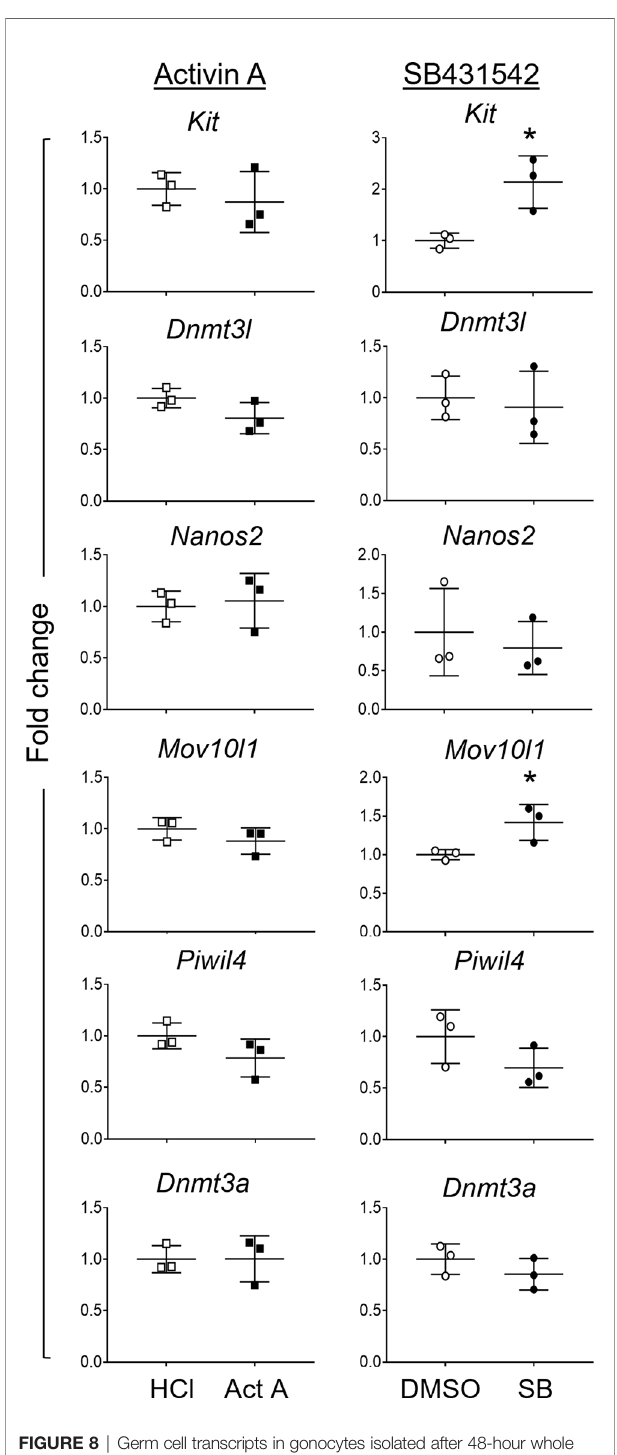
FIGURE 8 | Germ cell transcripts in gonocytes isolated after 48-hour whole testis culture. Germ cells were isolated via FACS from E13.5 testes cultured for 48 hours with 50 ng/mL activin A (Act A, black squares) or 10 µM SB431542 (SB, black circles) and their controls (white symbols). Transcripts of germ cell genes were measured by qRT-PCR. Treatment groups are presented as fold change compared to control (n=3 individual testes per group). Data were normalised to the Canx housekeeper gene, and presented as mean ± SD. Signi fi cance was determined by a Mann-Whitney test or Student's t-test following the Shapiro-Wilk normality test, and indicated by asterisk (*p <